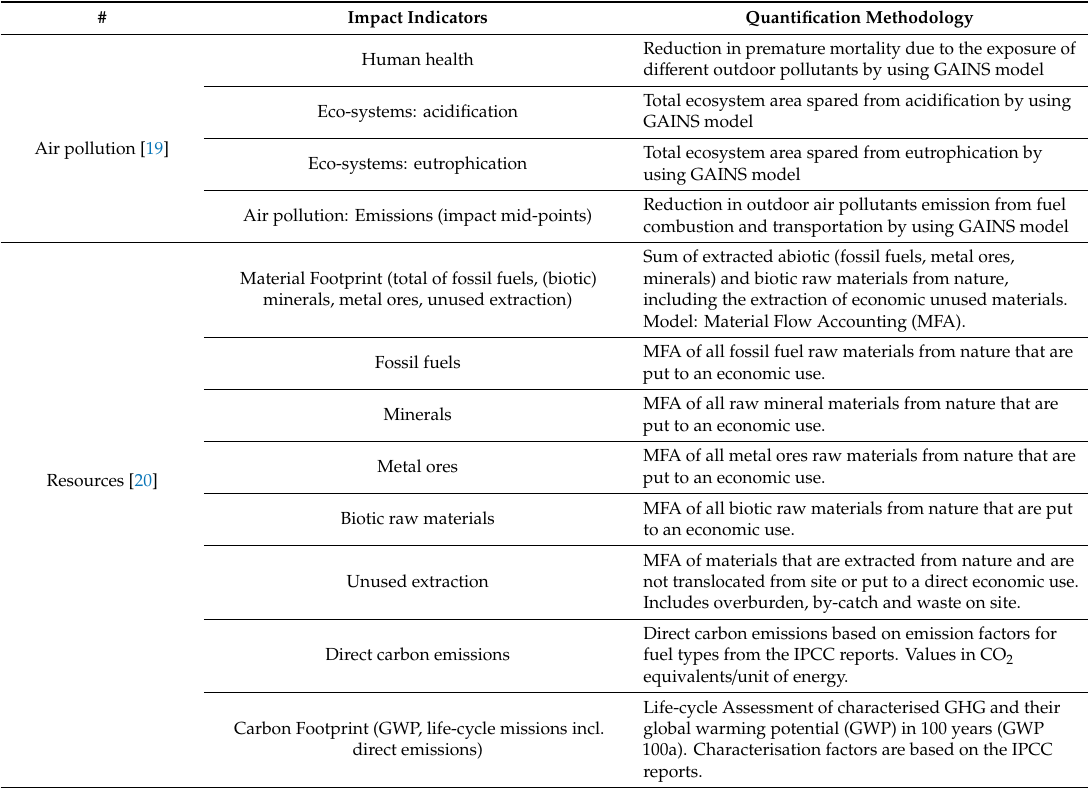
Table A1. Overview of COMBI impact indicators and respective quantification